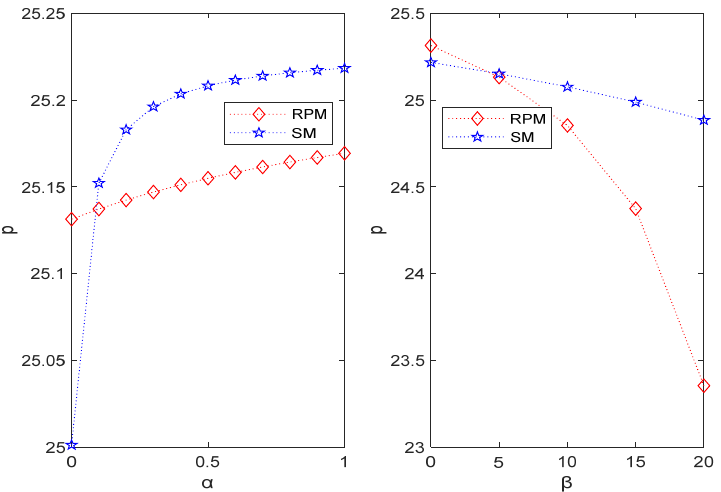
Figure 4. Retail price under RPM and SM vs. fixed cost coefficient ( left ) and environmental benefit coefficient ( right ).